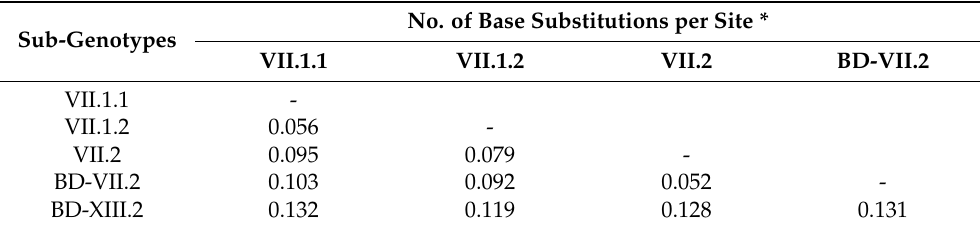
Table 2. Estimates of evolutionary distance between different sub-genotypes of class II genotype VII Newcastle disease viruses and the Bangladeshi isolates studied